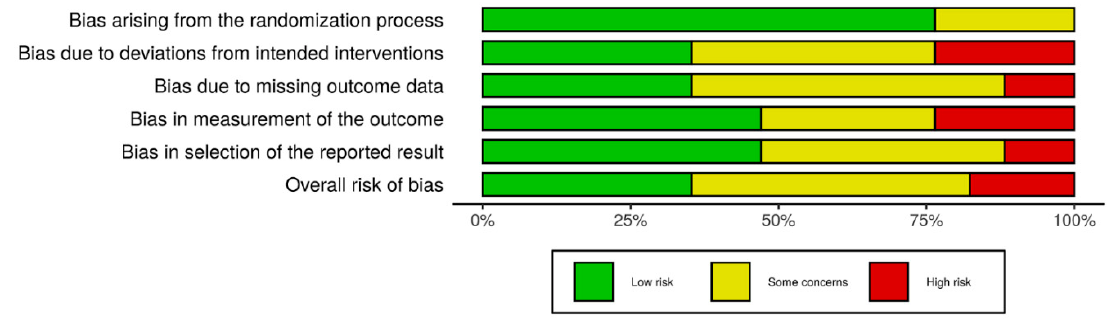
Figure 3. Risk of bias across studies. Excluding the first domain, some concerns and high risk of bias predominated in the rest of them, indicating an important bias by considering the results of all the studies.